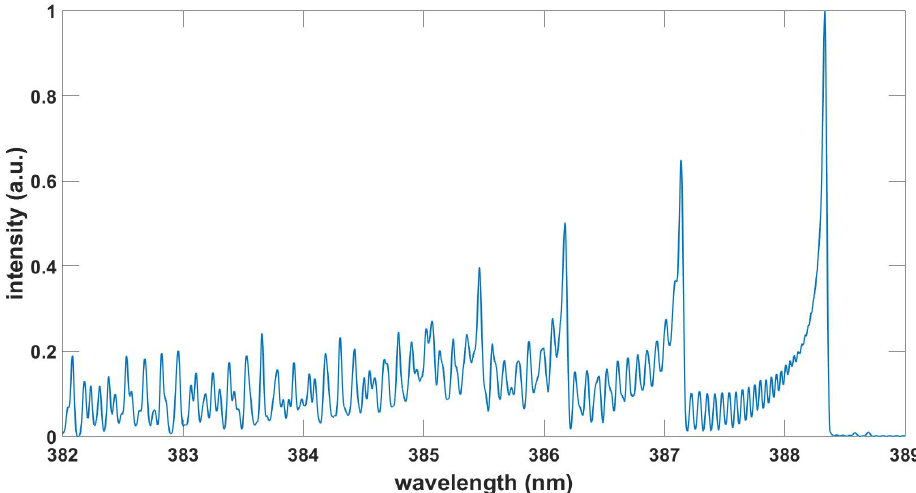
Figure 4. Computed CN violet spectrum, ∆ v = 0, δ λ = 0.030nm, T = 7.94